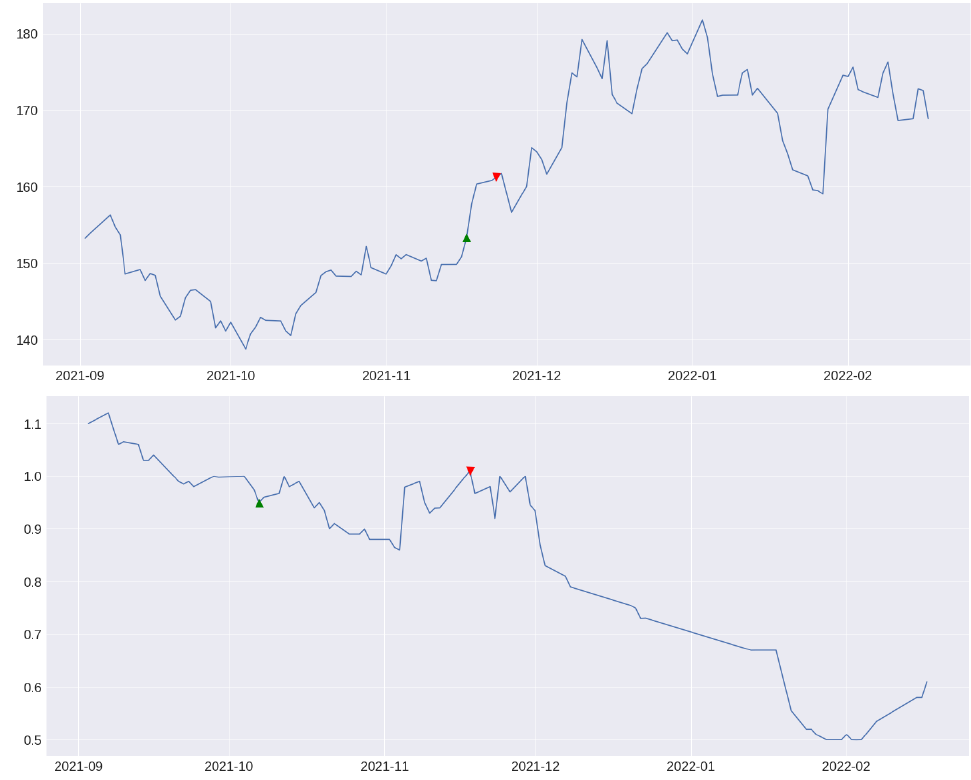
Figure 11. TI-SiSS results for Apple ( upper part ) and for Jones ( lower part ).